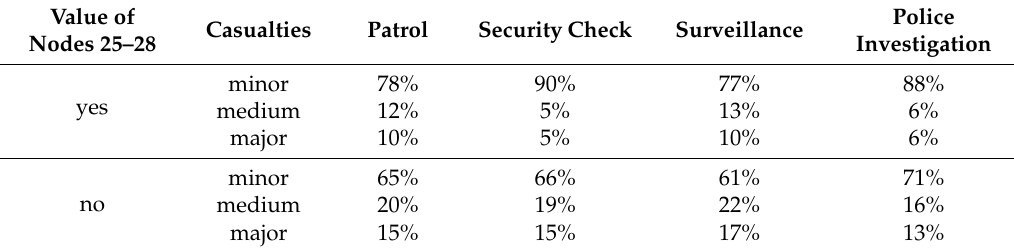
Table 5. Sensitivity of “Casualties” to patrol, security check, surveillance, police investigation.